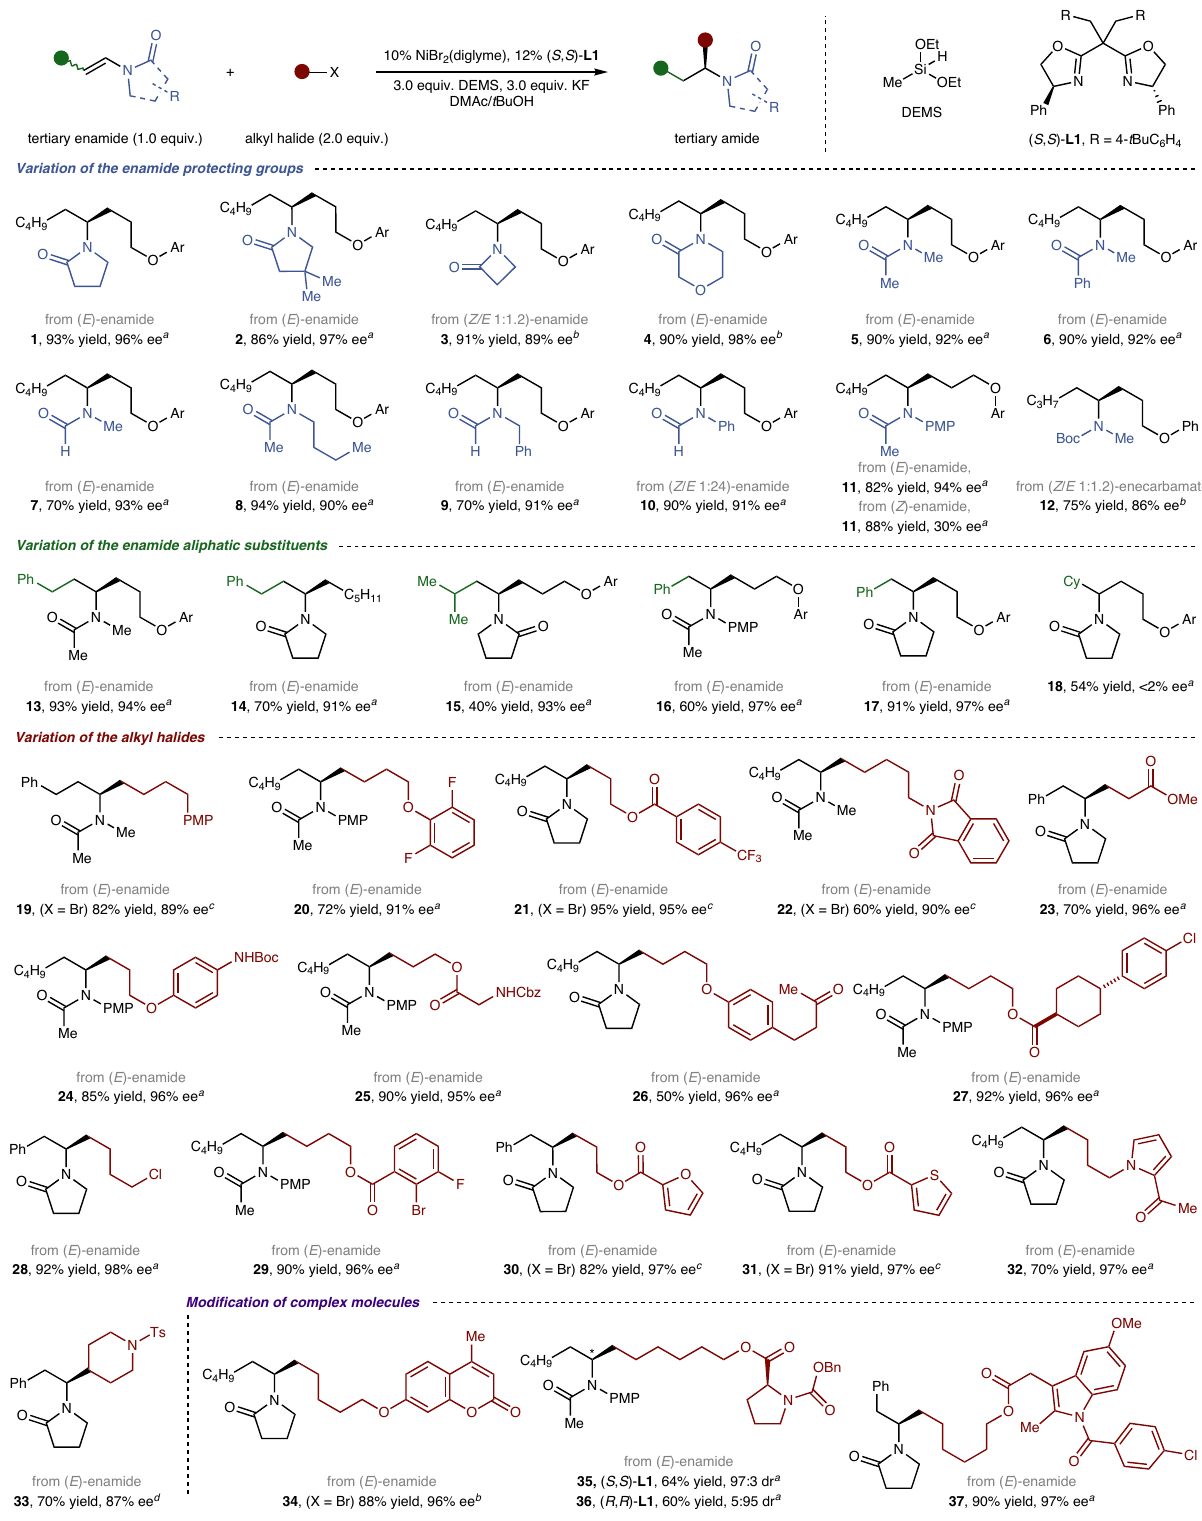
Fig. 2 Asymmetric reductive hydroalkylation of tertiary enamides. a DMAc: t BuOH (v/v = 5:4, 0.25 M), 25 °C, 20 h, isolated yield, 0.20 mmol scale. b DMAc: t BuOH (v/v = 5:4, 0.25 M), 5 °C, 30 h, isolated yield, 0.20 mmol scale. c DMAc: t BuOH (v/v = 5:4, 0.25 M), NaI (0.5 equiv.), 35 °C, 20 h, isolated yield, 0.20 mmol scale. d DMAc: t BuOH (v/v = 5:4, 0.25 M), 50 °C, 20 h, isolated yield, 0.20 mmol scale. e Diastereocenters marked with an asterisk symbol. Ar = 2-naphthyl, Diglyme = 2-methoxyethyl ether, DMAc = N , N -dimethylacetamide, PMP = p -methoxyphenyl, Boc = tert -butoxycarbonyl, Cbz = carbobenzyloxy, Ts = tosyl, Bn = benzyl, dr = diastereomeric